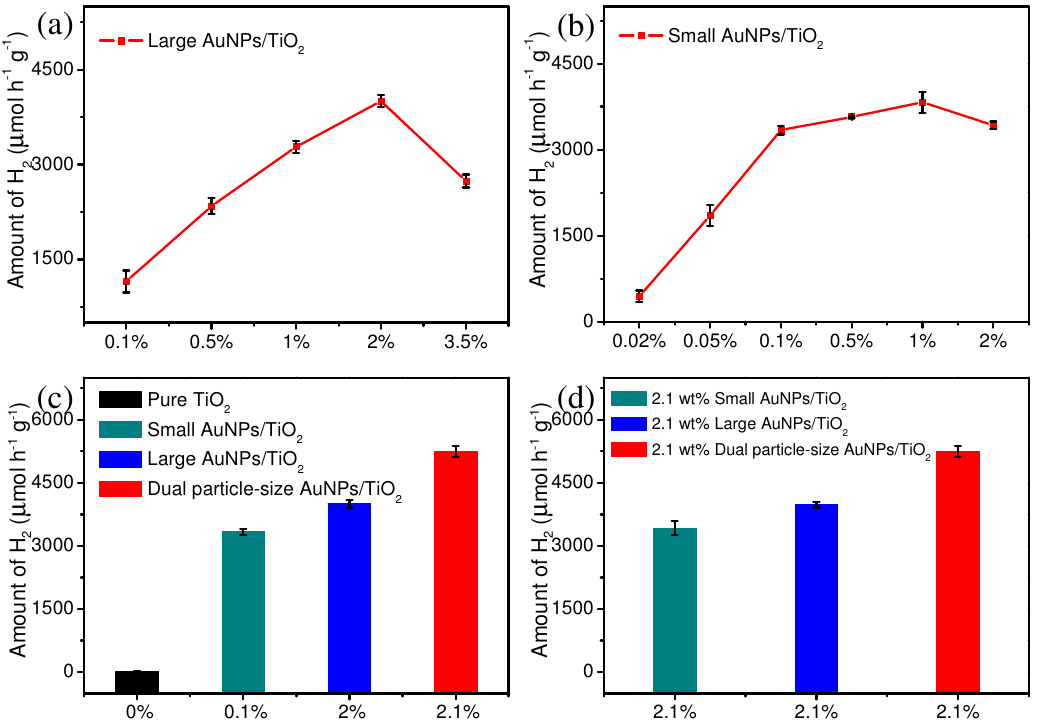
Figure 2. ( a , b ) Photocatalytic H 2 generation rates for different concentrations of large AuNPs/TiO 2 and small AuNPs/TiO 2 photocatalysts under light irradiation (350–780 nm). ( c ) Photocatalytic H 2 generation rates of pure TiO 2 , small AuNPs/TiO 2 , large AuNPs/TiO 2 , and dual particle-size AuNPs/TiO 2 photocatalysts under light irradiation (350–780 nm). ( d ) Photocatalytic H 2 generation rates of 2.1 wt% small AuNPs/TiO 2 , 2.1 wt% large AuNPs/TiO 2 , and 2.1 wt% dual particle-size AuNPs/TiO 2 under light irradiation (350–780 nm).